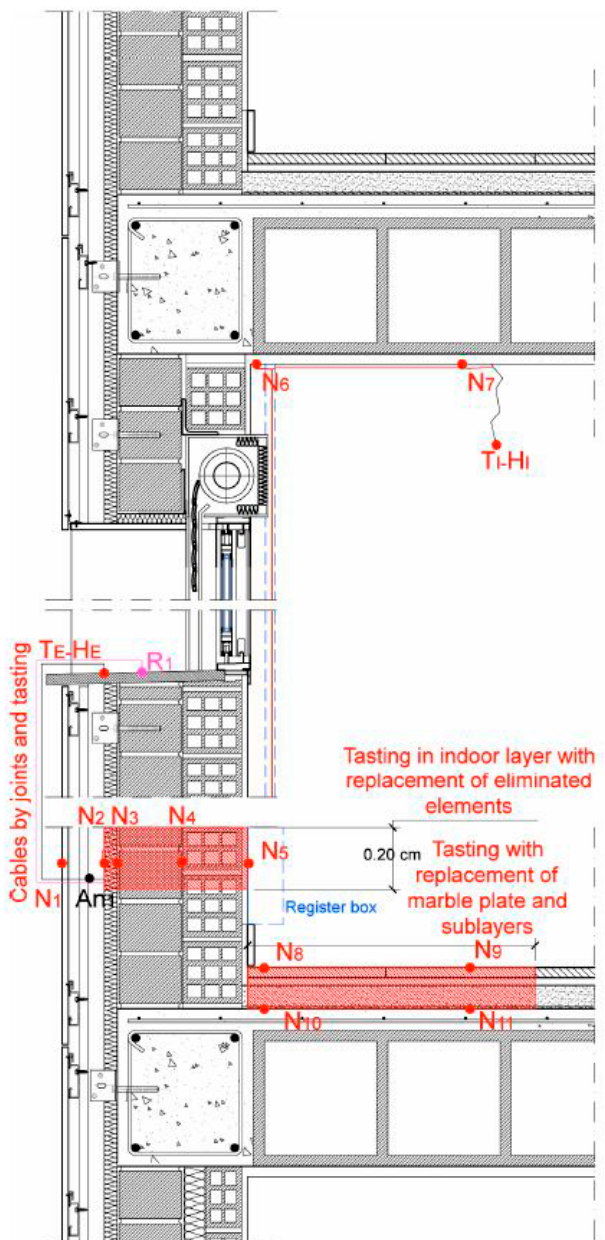
Figure 10. The sensor location chart .